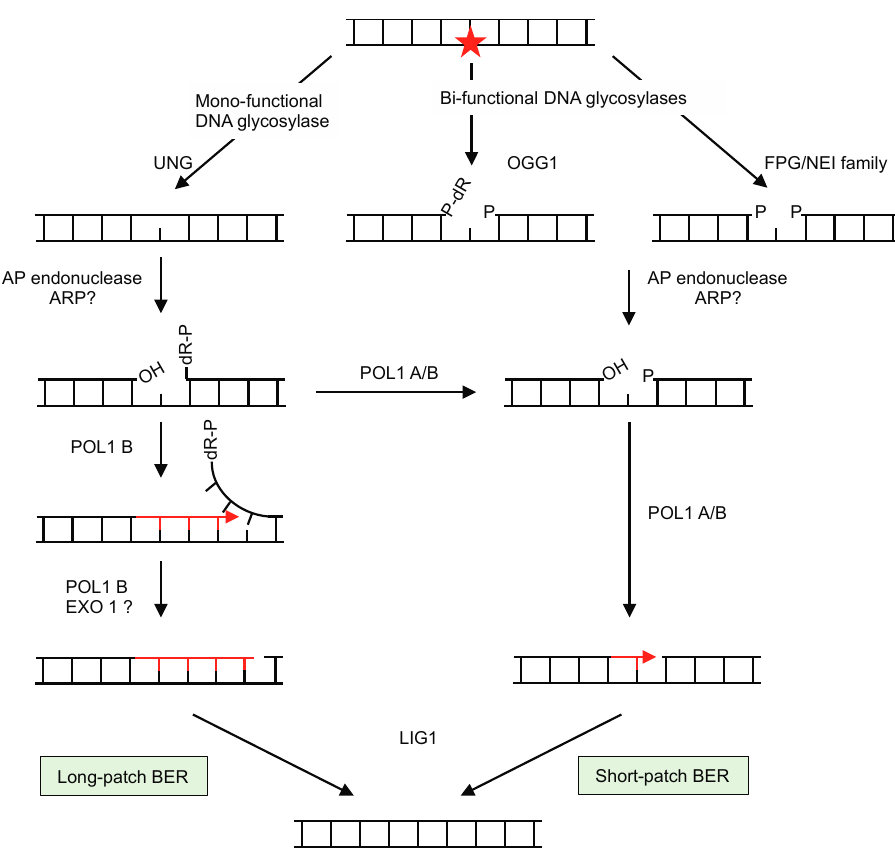
Figure 1. Mechanisms of base excision repair (BER). BER involves recognition and removal of base lesions (star) by glycosylases, and depending on the lesion and type of glycosylase it either follows the long-patch or short-patch pathways. Monofunctional glycosylases generate apurinic/apyrimidinic (AP) sites, while bifunctional glycosylases have AP lyase activity and leave a nucleotide gap with either a 3 ′ blocking sugar (P-dR, after 8-oxoguanine glycosylase OGG1 activity) or with 5 ′ - and 3 ′ -phosphate (P) groups at the termini (after the action of glycosylases of the formamidopyrimidine glycosylase/endonuclease VIII (FPG)/NEI) family). The activity of AP-endonuclease on the gaps left by bifunctional glycosylases will leave them ready for filling in and ligation by DNA polymerase (DNAP) and ligase, respectively, by short-patch repair. The AP sites left by monofunctional glycosylases are cleaved at the 5 ′ - side by AP endonuclease, which leaves 3 ′ -OH and 5 ′ -P termini. Strand displacement by DNAP replaces 2–10 nucleotides by the long-patch pathway, and a nuclease is required to cleave the 5 ′ dR-P (EXO1). Alternatively, long-patch intermediates can be converted to short-patch ones by the activity of the DNAP.